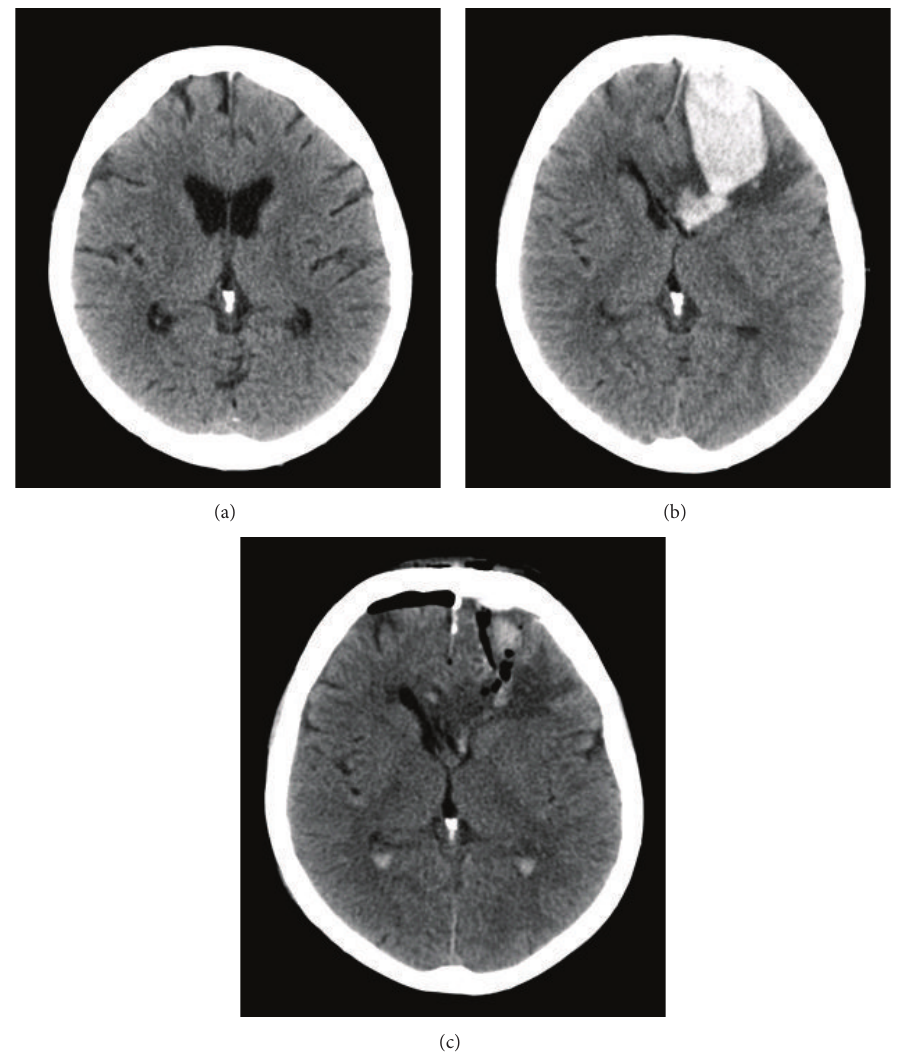
Figure1:CTimagesperformedinitiallyaftertheheadinjury(a),afterneurologicaldeterioration(b),andaftersurgicalhaematomaevacuation